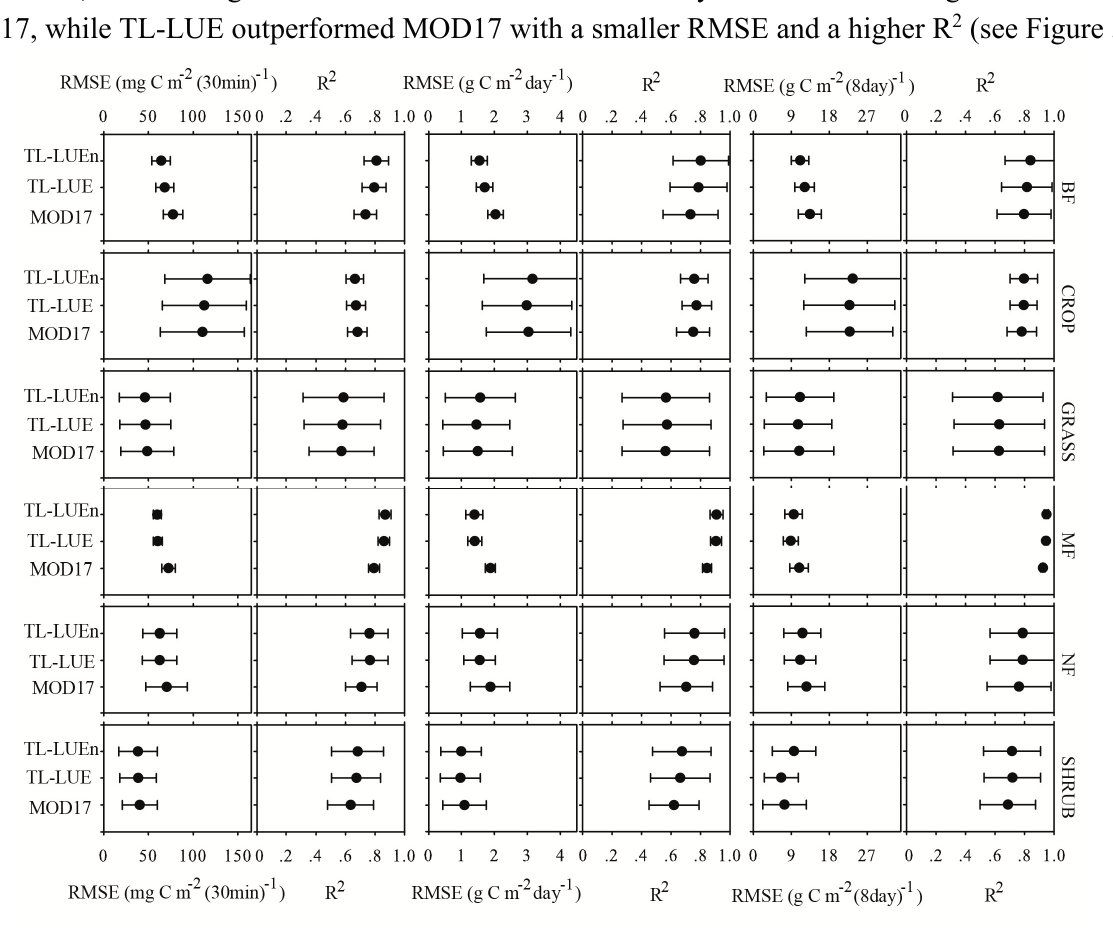
Figure 5. Average RMSE and R 2 of GPP simulated using calibrated TL-LUEn, TL-LUE and MOD17 in the validation site-years at half-hourly (the first and second columns), daily (the third and fourth columns), and 8-day (the last two columns) scales for individual vegetation types. Note: Broadleaf forest (BF); Mixed forest (MF); Needleleaf forest (NF); Crop (CROP); Grass (GRASS); Shrub (SHRUB). Solid black circles are the means and horizontal error bars denote standard